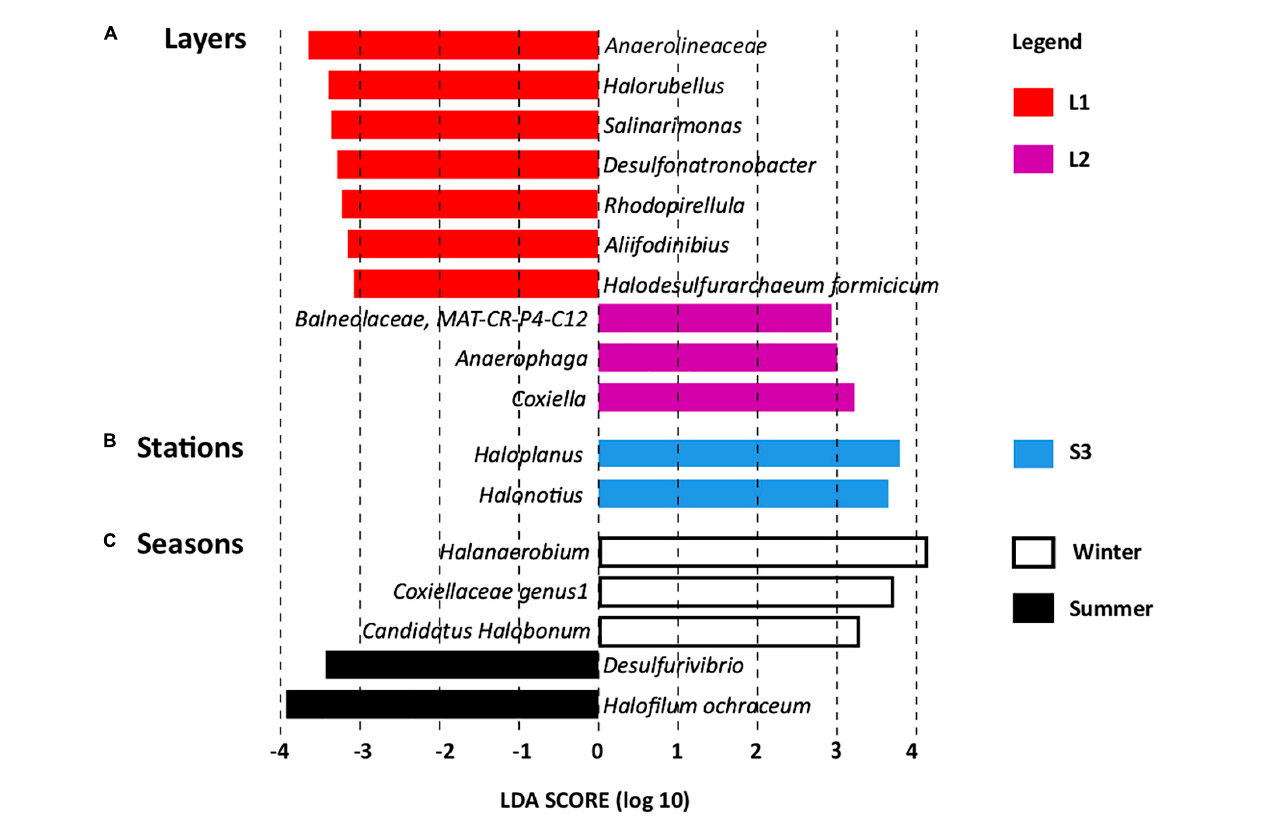
FIGURE4 Linear discriminant analysis effect size (LEfSe) identifying microbial genera specifically more abundant according to (A) layers (L1 and L2), (B) stations (S1, S2, and S3), and (C) seasons (summer and winter, dry and wet periods,